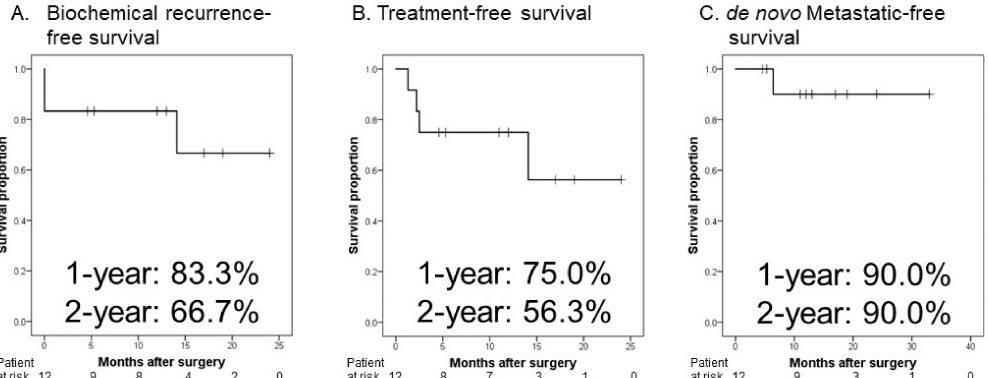
Figure 1. Kaplan–Meier estimates of oncological outcomes in patients with metastatic prostate